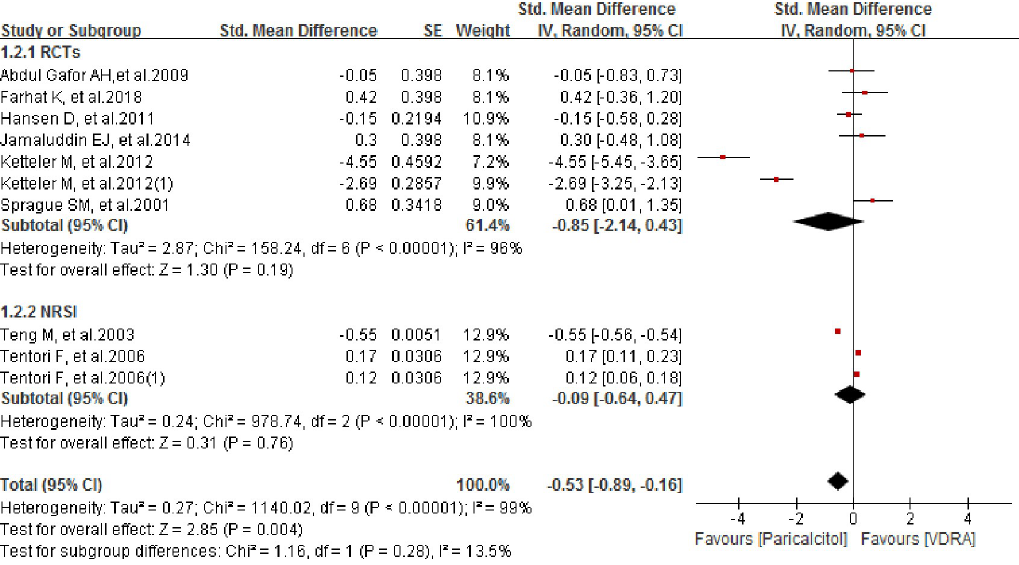
Fig 5. Forest plot of comparison between paricalcitol and VDRA regarding to intact parathyroid hormone level.